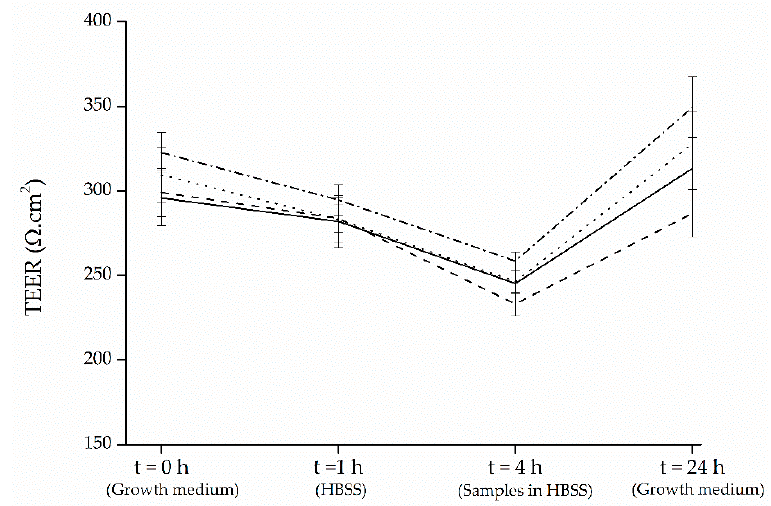
Figure 3. TEER (transepithelial electrical resistance) measurements carried out in growth medium (Dulbecco’s Modified Eagle Medium, DMEM, with Glutamax, 10% fetal bovine serum, FBS, 1% Pen Strep and 1% nonessential amino acids, NEAA) and during incubations in Hank’s Balanced Salt Solution (HBSS). Data represent mean values ± SD (3 biological and 3 technical replicates). Solid line corresponds to the blank (no treatment); dashed line to black carrot; dotted line to strawberry; dashed-dotted line to the mixture black carrot-strawberry.